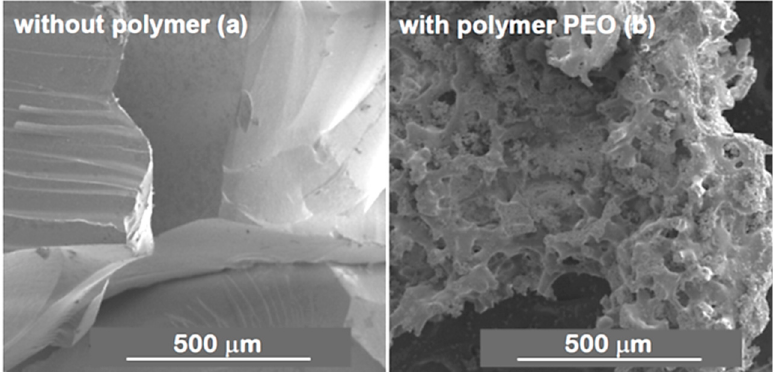
Figure 10. SEM photomicrographs of heat-treated monoliths of composition 70%SiO 2 –30%CaO (mol%), prepared by ( a ) the sol-gel technique without addition of PEO and ( b ) the sol-gel/phase separation technique with addition of PEO. Reprinted by permission from Springer: Springer Nature, Journal of Materials Research, Sol-gel-derived glass scaffold with high pore interconnectivity and enhanced bioactivity, A.C. Marques, R.M. Almeida, A. Thiema, S. Wang, M.M. Falk and H. Jain [58]. Copyright Springer Nature 2009.